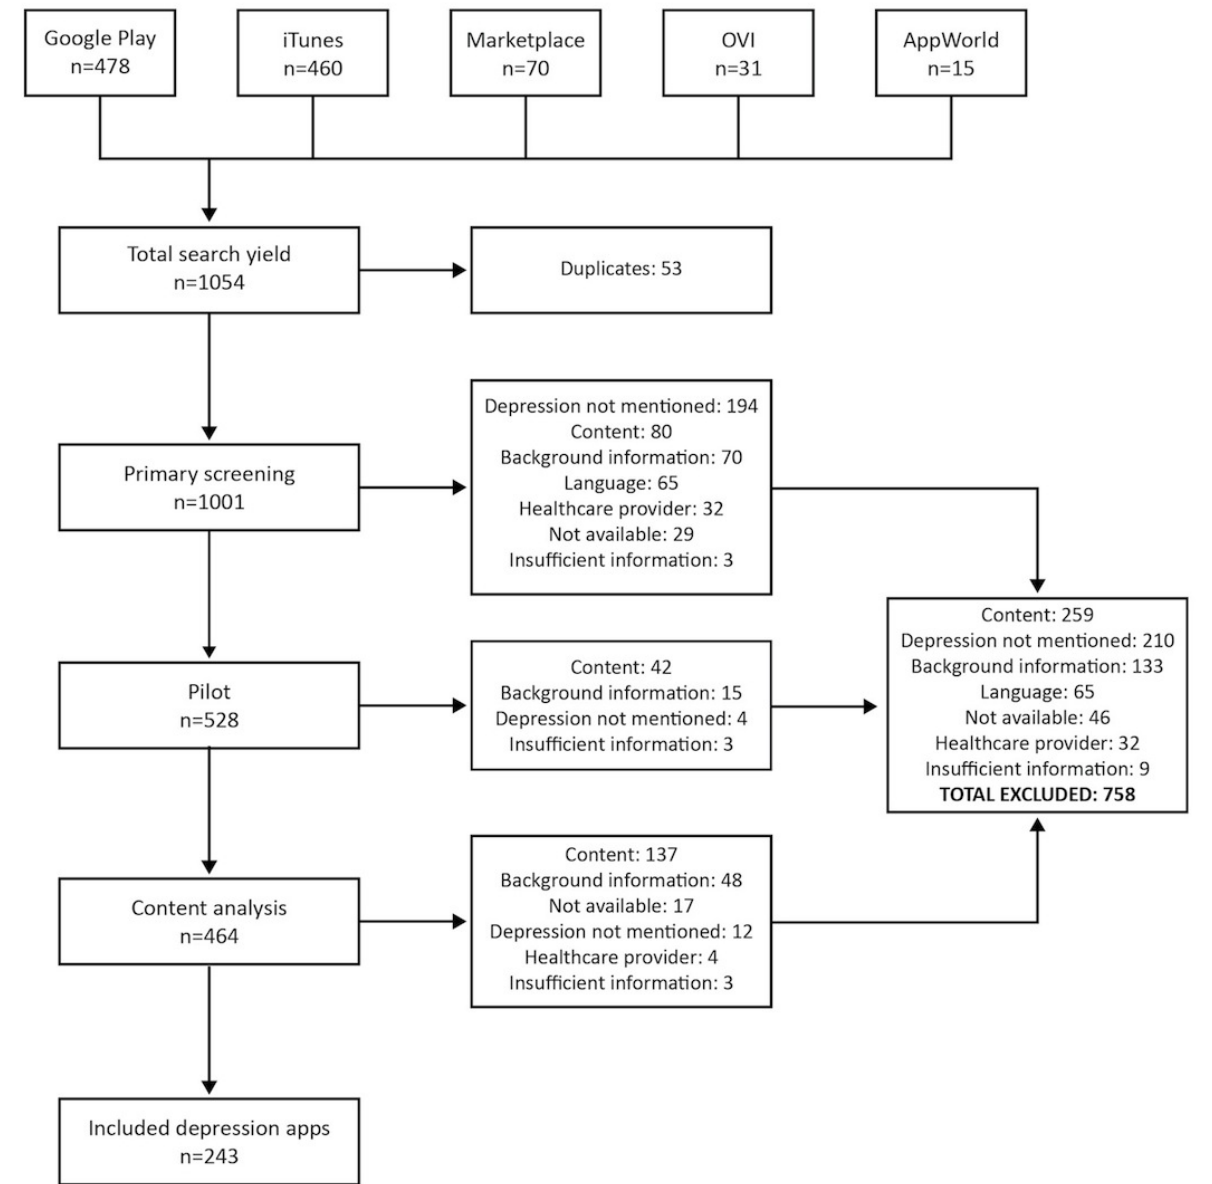
Figure 1. Flow diagram illustrating the exclusion of apps at various stages of the